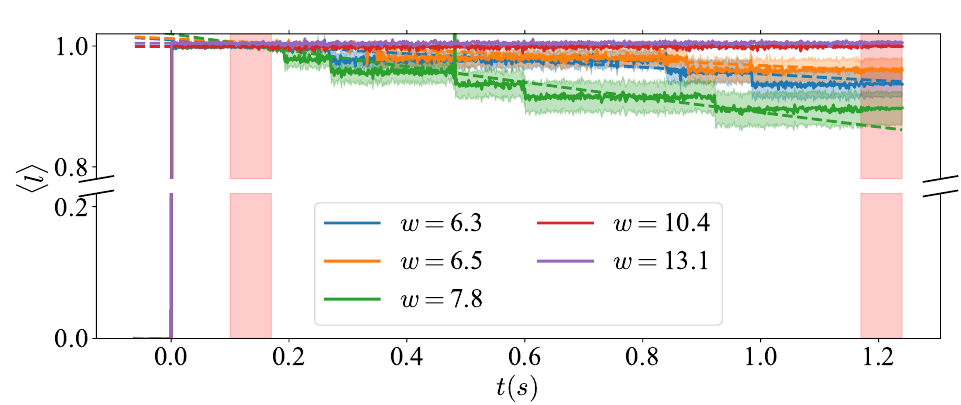
Figure 14: Average winding number as a function of time, for the temperature T = 195nK, and different values of the barrier width w , given in microns. The bar- rier width used for the main results of this paper is w = 6 µ m. Increasing the barrier height slightly (roughly 10 − 20%) does not significantly affect the rate of decay, at least not enough to account for the discrepancy with the experiment. More dramatic increases of the barrier width ( ∼ 100%) result in the suppression of the decay al- together. Shaded regions give a 95% confidence interval for the winding number, which is computed as the ensemble average over 48 trajectories.